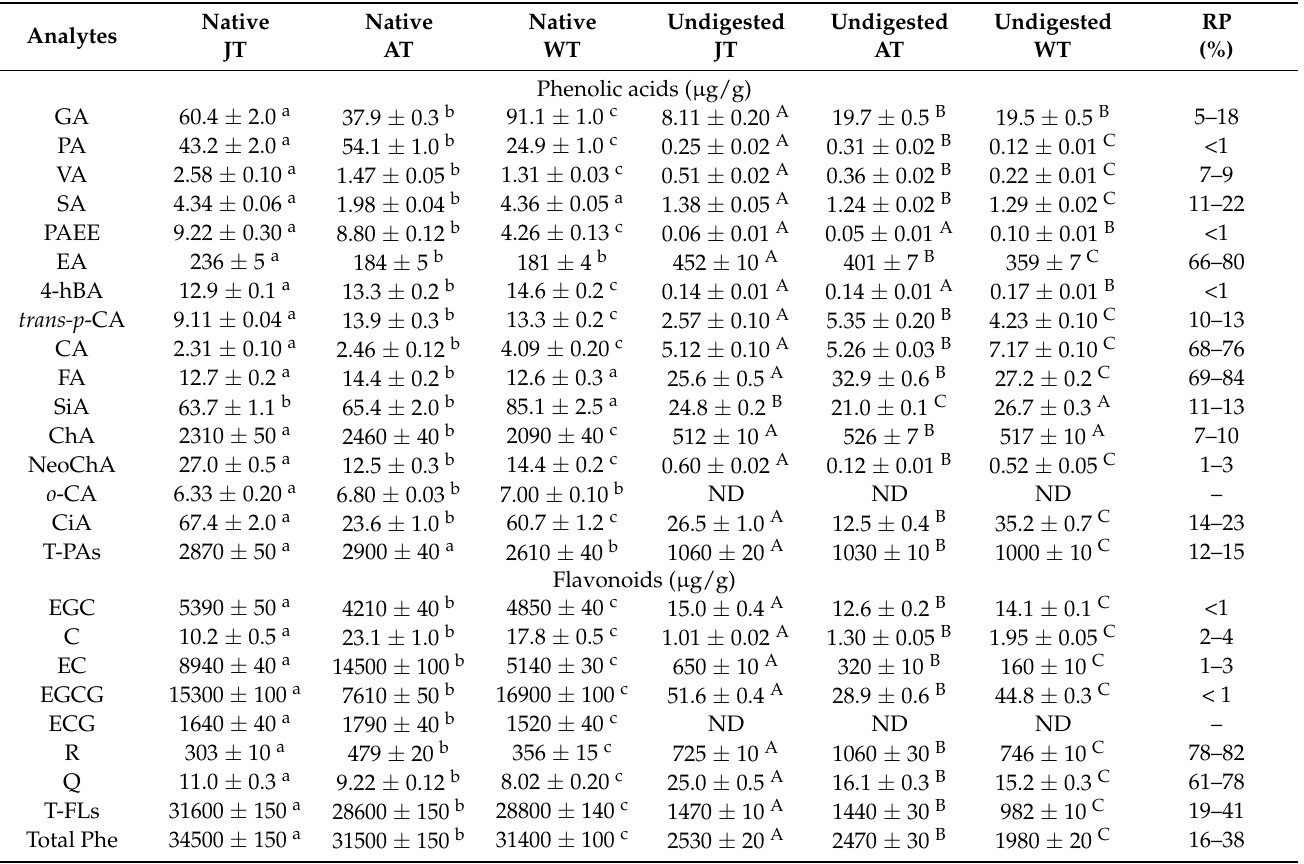
Table 2. Phenolic acid and flavonoid compounds determined in native and undigested parts of matcha